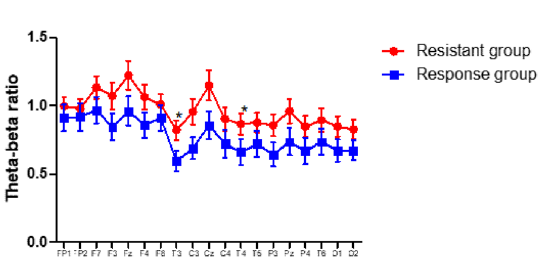
Figure 1. Topographic maps between channel in each frequency. The topographic maps represent the probability of analysis of covariance (ANCOVA) between two groups. A colored area means an increase of difference in absolute powers. In beta wave and high-beta wave, significant differences showed in T3 and T4.